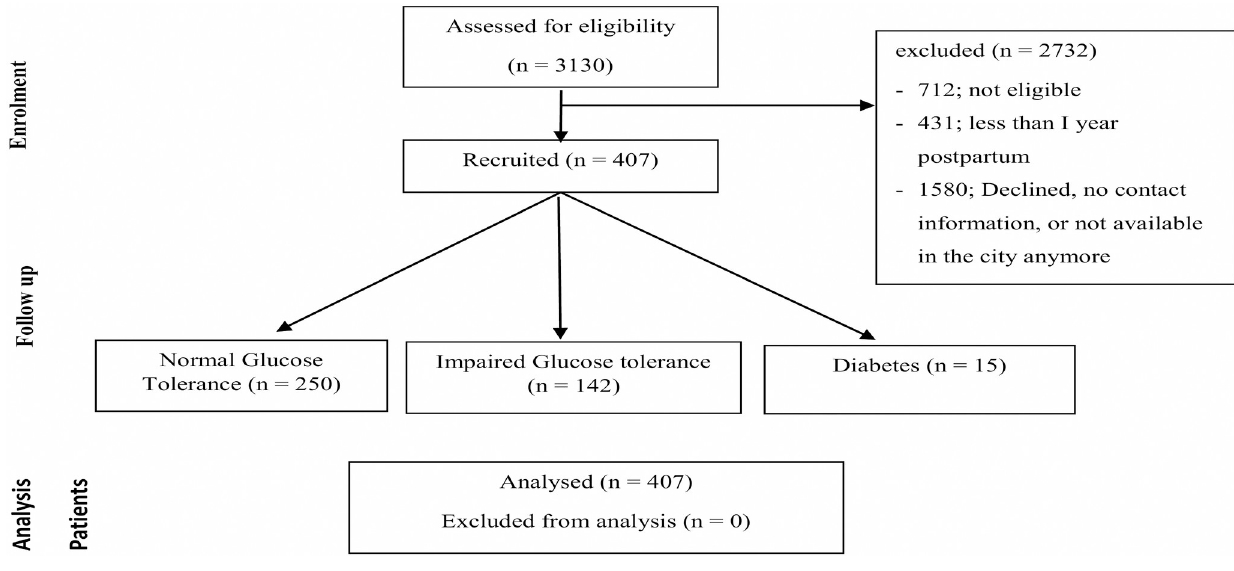
Fig 1. Recruitment and analysis of the